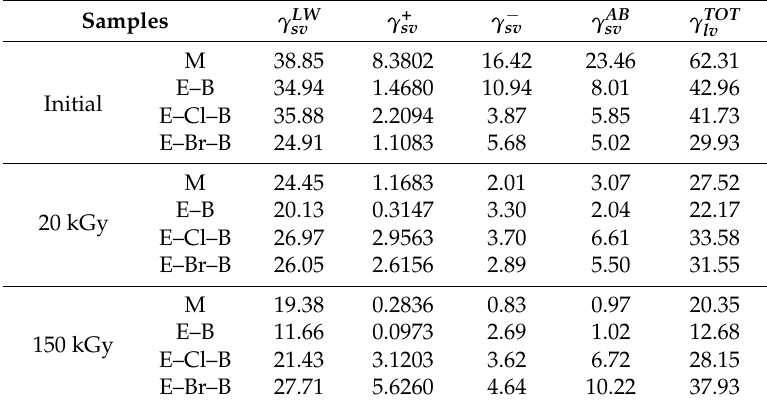
Table 9. Surface free energy values and components for sample surfaces; all values are expressed in